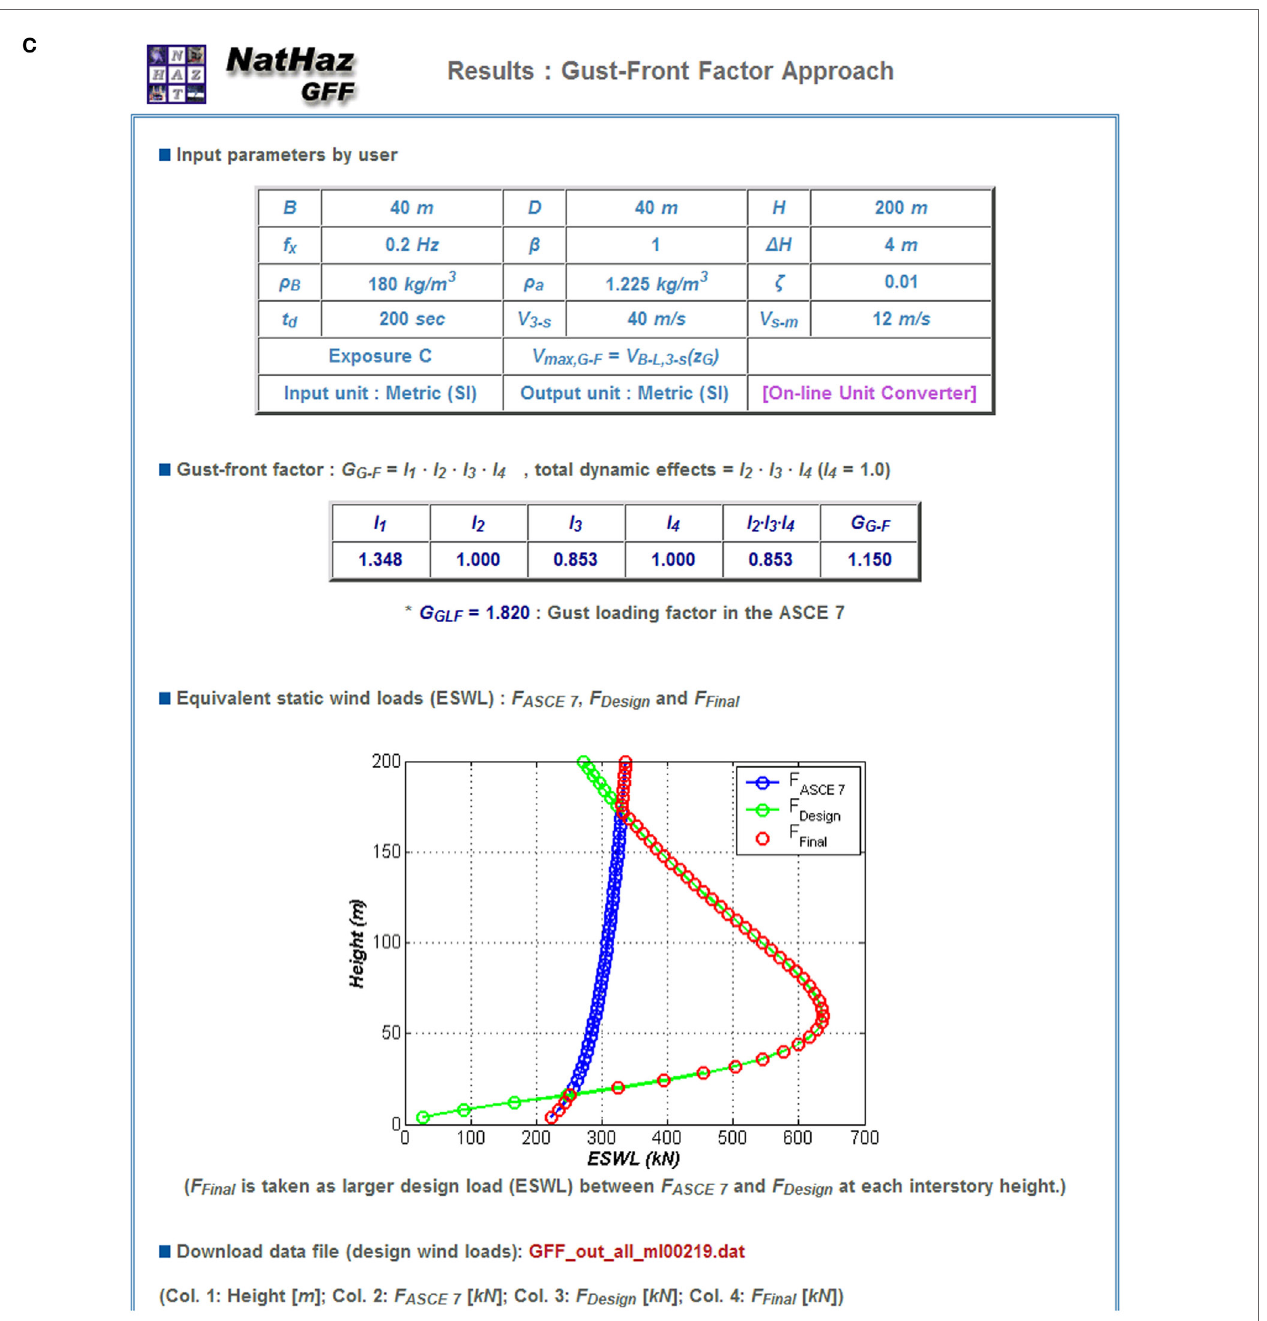
FigUre 8 | Gust-front factor framework: (a) Schematic diagram. (B) Web-based user interface. (c) Result